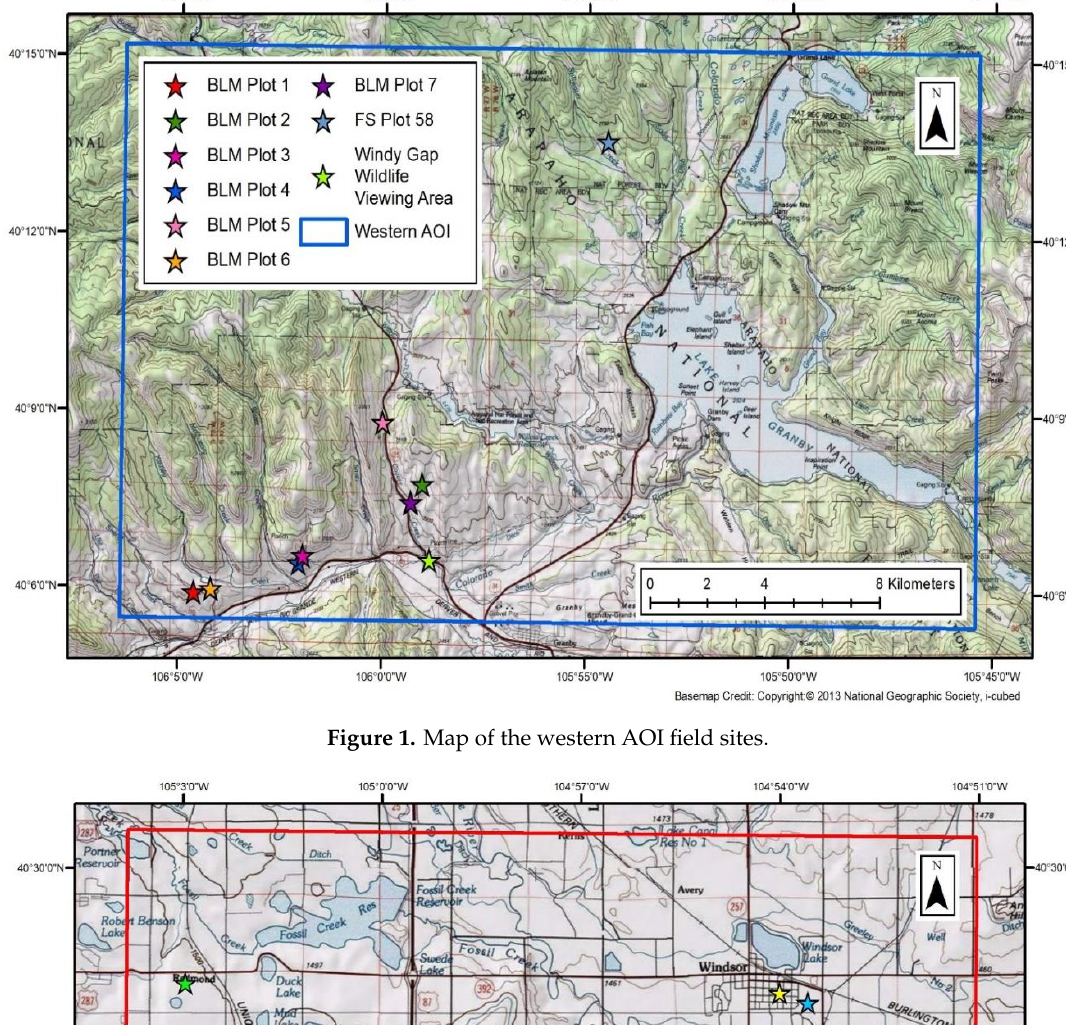
Figure 1. Map of the western AOI field sites.